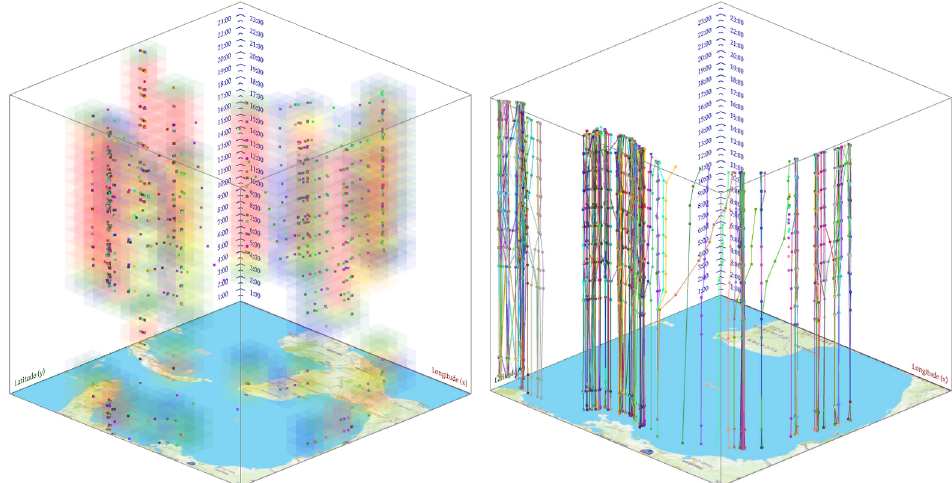
Figure 13. Pelican trajectories: on the ( left ), wintering; on the ( right ),